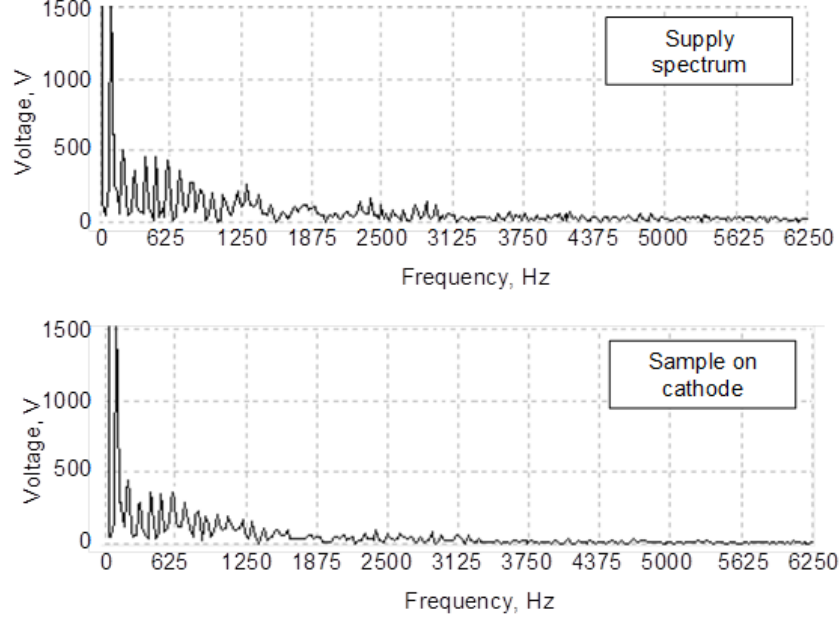
Figure 11. Comparison of the Fourier spectrum of voltage variations on the surface of the sample galvanically connected with the cathode with the power supply voltage spectrum.